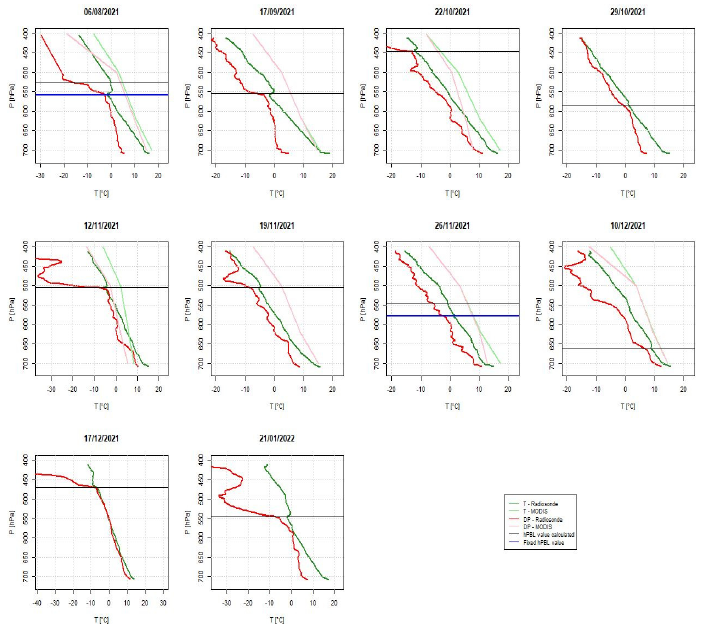
Figure 12. Temperature and dewpoint temperature pressure profiles from radiosonde and MODIS with the calculated hPBL value for ten measurement events. with the calculated hPBL value for ten measurement